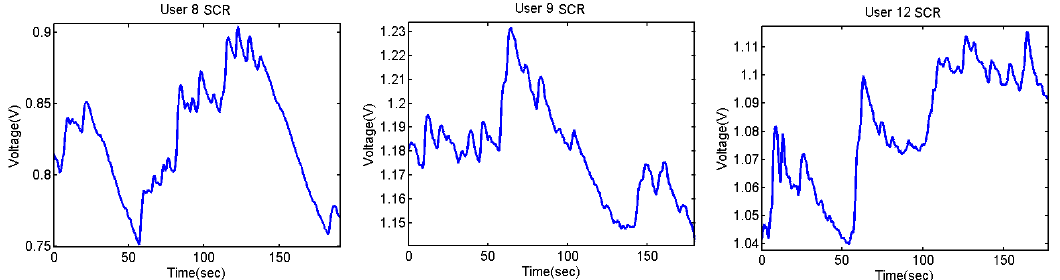
Figure 29. Skin response of users 8, 9 and 12 from Stoop Test.